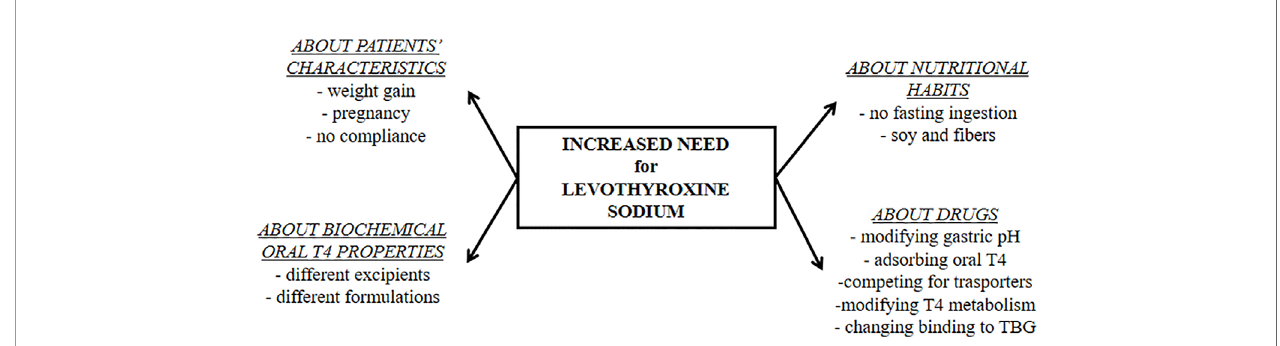
FIGURE 2 | The physiologic and pharmacologic biases of oral levothyroxine treatment that must be excluded before starting a diagnostic workup for malabsorptive